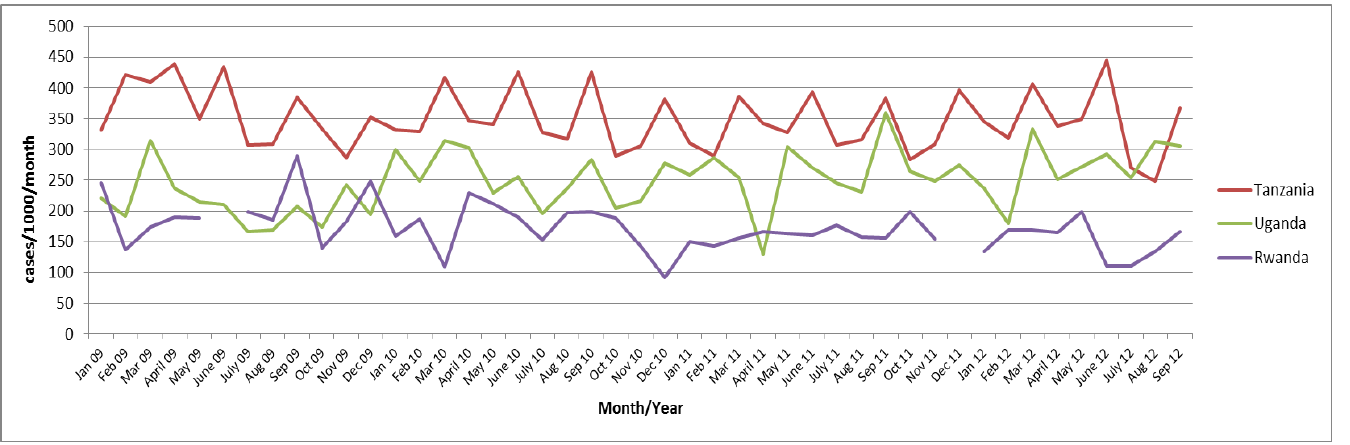
Source: Office of the United Nations High Commissioner for Refugees (UNHCR), Health Information System